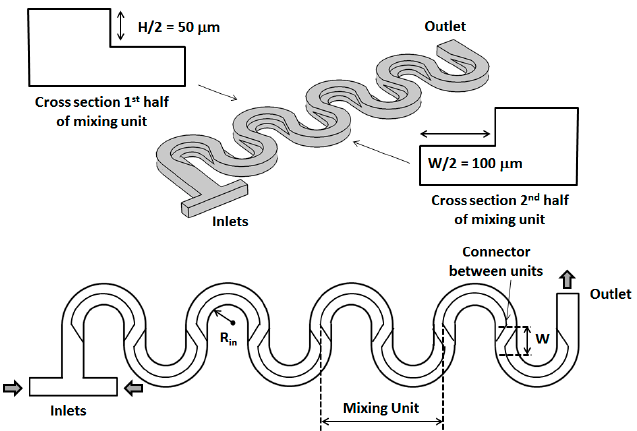
Figure 2. 3D and top views of the new serpentine micromixer design employing non-rectangular cross-sections. As shown above, the orientation of the cross-section of the mixer is changed after each turn of the serpentine.